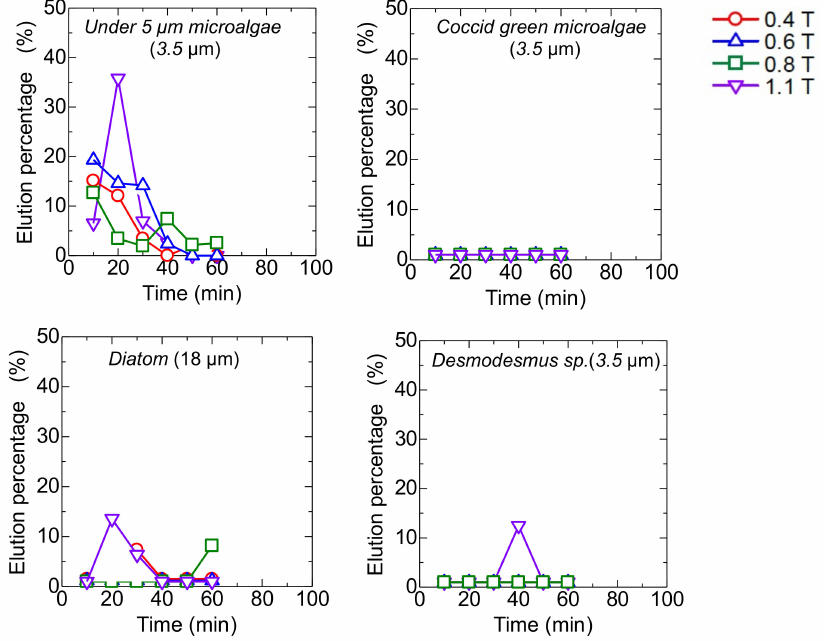
Figure 5. Time-course curves of eluted each type of microalgae from a bed of Mag gel in applying a static magnetic